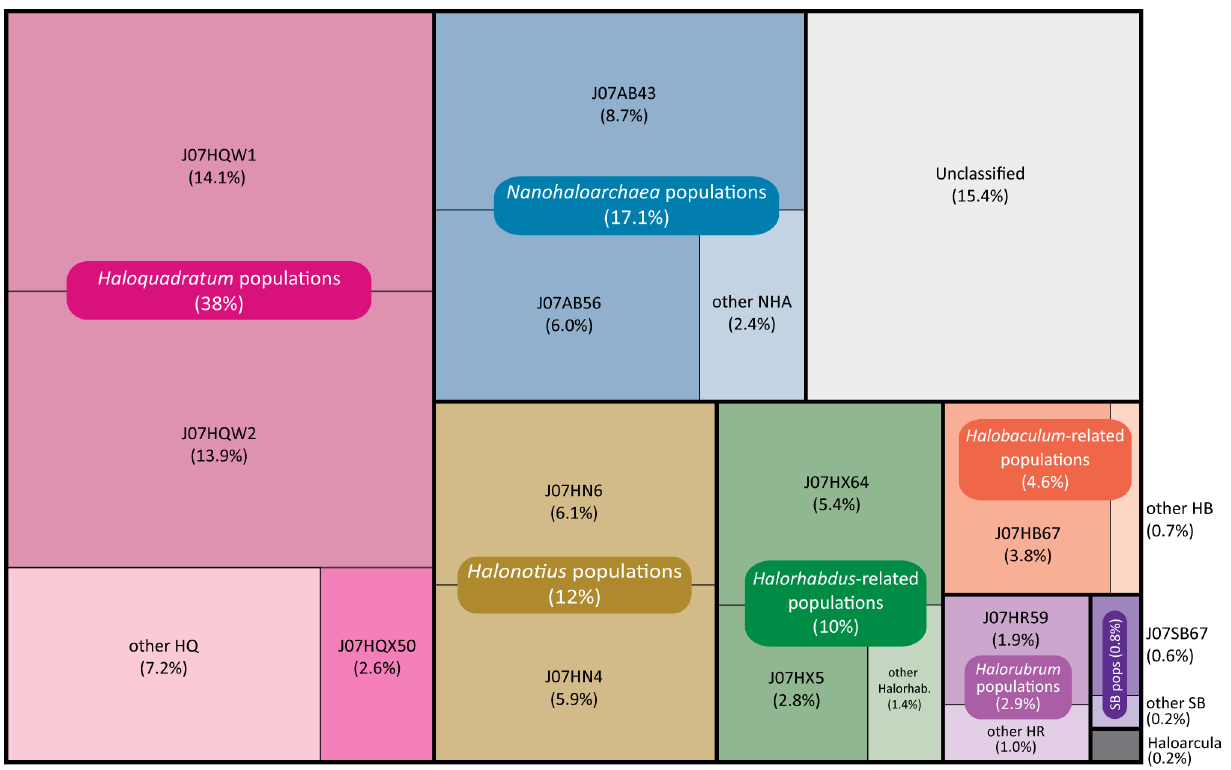
Figure 3. Relative abundance of microbial population groups. Colors correspond to taxonmically related microbial populations, including both assembled genome sequences and non-genomic scaffolds containing less abundant variant sequences. Percentage calculations include total number of assembled nucleotides in reads associated with each group, normalized for the group’s average genome size. Percentage of unclassified sequences was calculated using an estimated genome size of 3 MB, the approximate abundance-weighted average for all other groups. Known viral and plasmid sequences, representing approximately 0.2% of assembled nucleotides, have been excluded from these calculations.